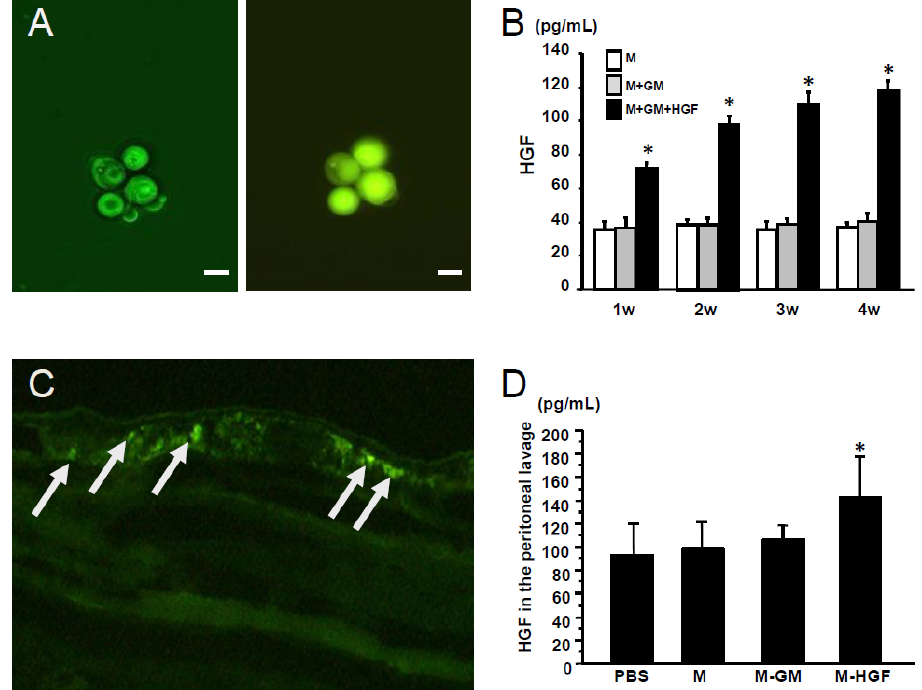
Figure 1. Confirmation of gene expression in the macrophages. ( A ) Left panel; macrophages phagocyte cationized gelatin microspheres (CGMs) incorporating green fluorescent protein (GFP) expression plasmid by light microscope. Right panel; in macrophages phagocyted CGMs, GFP expression was detected by fluorescence microscope. Scale bar; 100 mm, magnification; 40 × ; ( B ) Hepatocyte growth factor (HGF) levels in the culture medium. M; macrophages only, M + GM; macrophages and gelatin microspheres, M + GM + HGF; macrophages and gelatin microspheres incorporating HGF gene. * denotes a significant difference against the M group at p < 0.05. ( C ) Arrows show GFP expressing macrophages in the chlorhexidine gluconate (CG) induced fibrotic peritoneum at 1 week after transplantation. Magnification; 200 × ; ( D ) HGF levels in the peritoneal lavage fluid. Phosphate-buffered solution (PBS); CG injected mice administered PBS-CGMs, M; CG injected mice administered macrophages, M-GM; CG injected mice administered macrophages phagocyting CGMs, M-HGF; CG injected mice administered macrophages phagocyting CGMs incorporating HGF gene. * denotes a significant difference against the PBS group at p < 0.05. Table 1. The body weight and liver and renal functions in each group of mice. Data are expressed as mean ± standard deviation (SD). Phosphate-buffered solution (PBS); CG injected mice administered PBS-CGMs, M; CG injected mice administered macrophages, M-GM; CG injected mice administered macrophages phagocyting CGMs, M-HGF; CG injected mice administered macrophages phagocyting CGMs incorporating HGF gene. BW, body weight; AST, aspartate aminotransferase; ALT, alanine aminotransferase, BUN, blood urea nitrogen; Cr, creatinine. BW at Day BW at 0 (g)